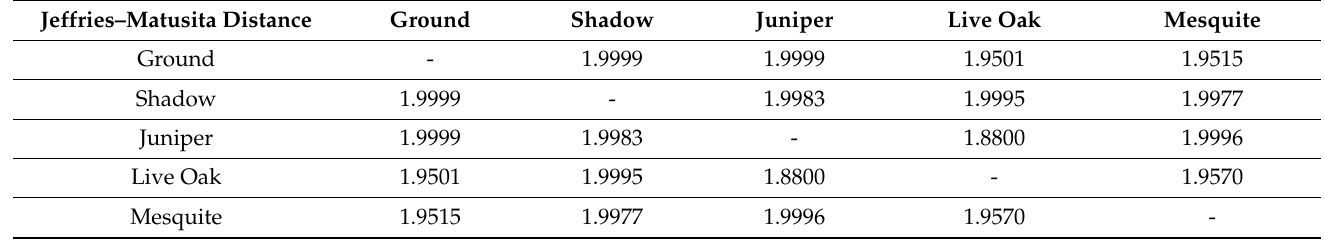
Table 1. Class separability values using Jeffries–Matusita distance.